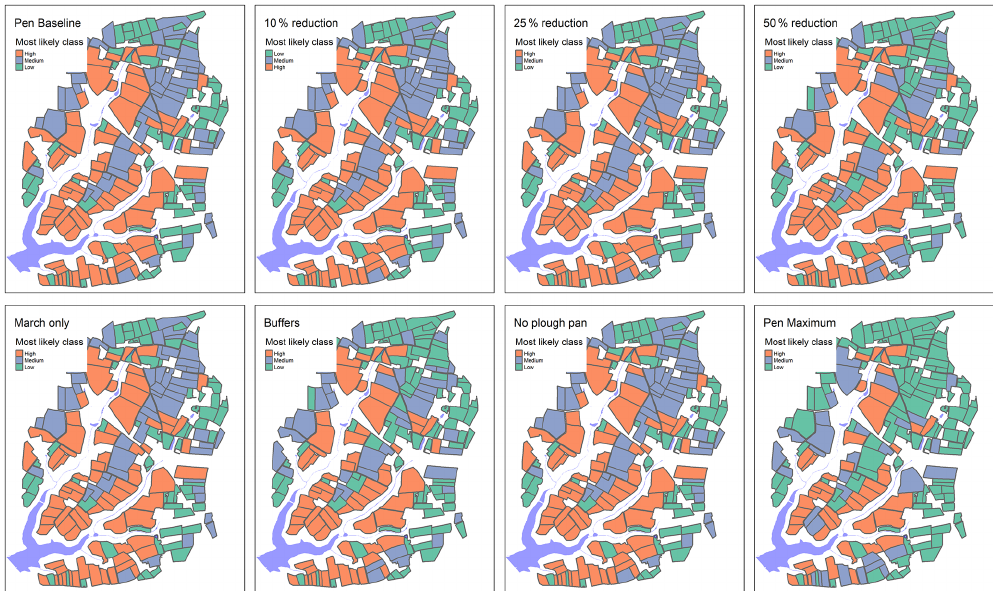
Figure B2. Most likely overland flow risk class for pendimethalin under current application practices; with a 10%, 25%, or 50% reduction in the application rate; with a time shift of application to March; with additional field buffers; with no plough pan; and with all mitigation measures